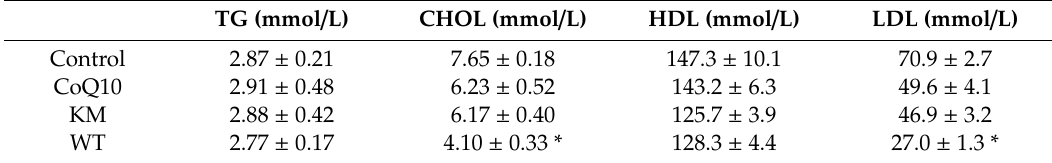
Table 3. Lipid profile of control, coenzyme Q10 (CoQ10), Koralovij Marka (KM), and Wild Type (WT)